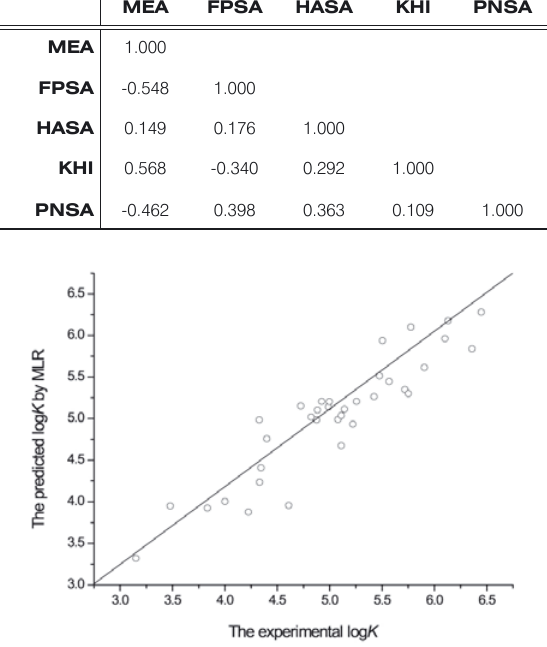
Figure 2. Experimental log K versus predicted log K by